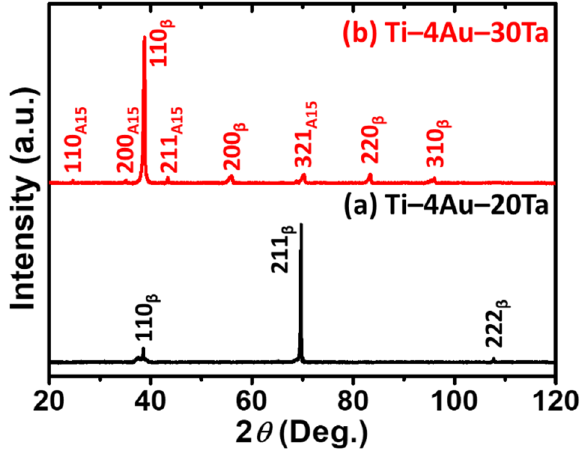
Figure 1. The X–ray diffraction patterns of the ( a ) Ti–4Au–20Ta alloy and the ( b ) Ti–4Au–30Ta alloy at RT under ambient.